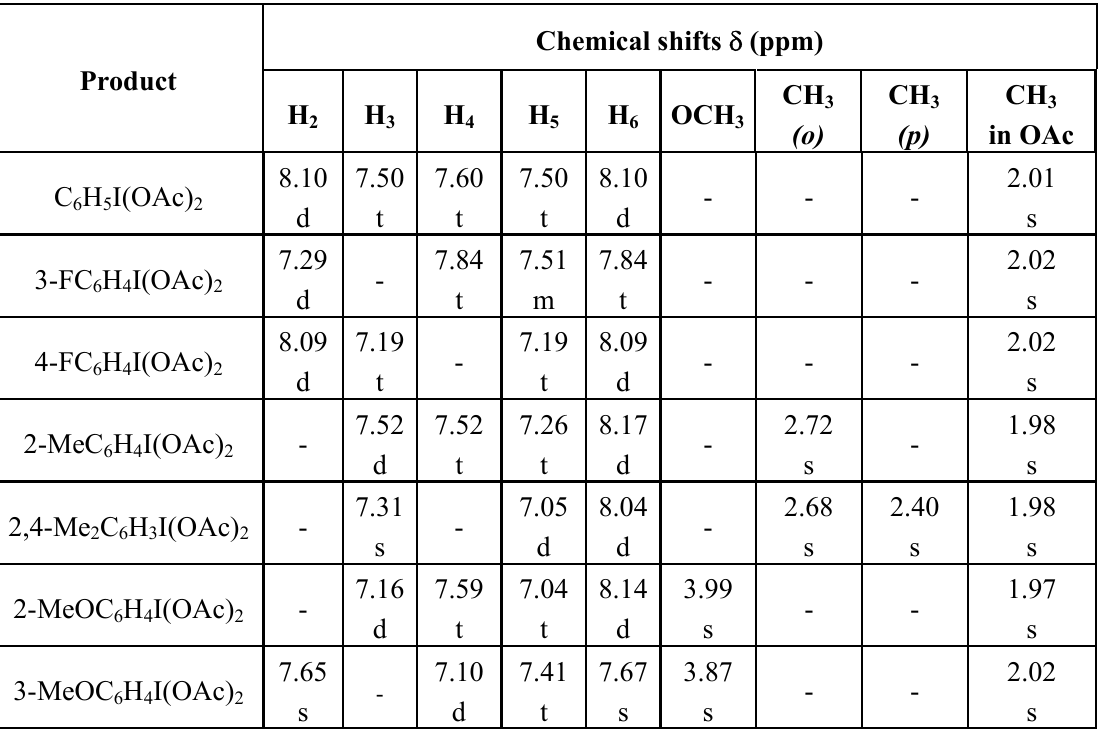
Table 2. 1 H-NMR chemical shifts for pure (diacetoxyiodo)arenes. Cf. our present experimental values with those previously reported